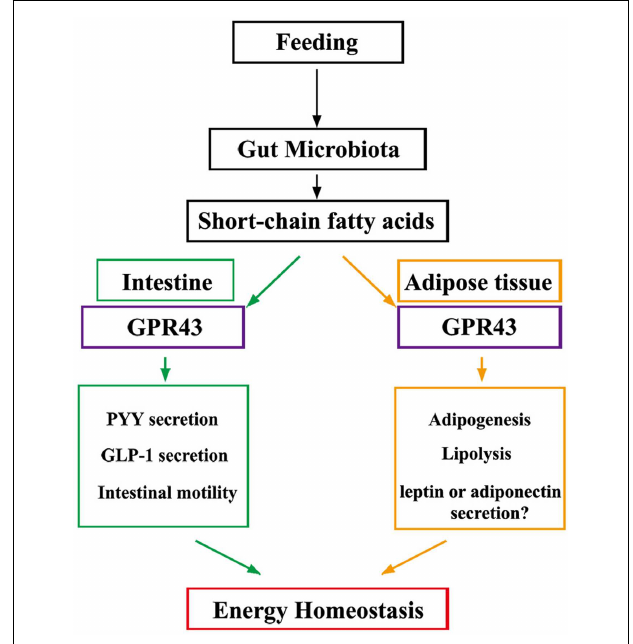
FIGURE 1 | Under “fed” conditions, SCFAs are produced in the gut by bacterial fermentation of dietary fiber . SCFAs alter the metabolic rate by stimulating GPR43 in adipocytes and promote gut hormone secretion and motility by stimulating GPR43 in the intestine, thereby increasing energy expenditure and improving glucose tolerance to increase energy